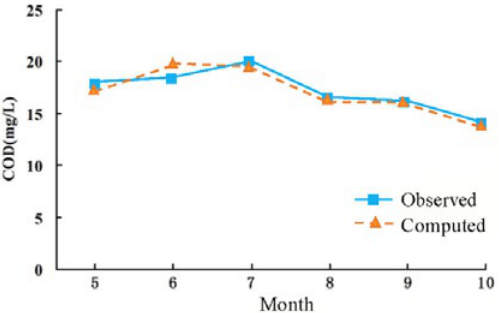
Fig. 6: Verification of COD Cr in Chenggaozi cross-sec (cid:415) on (2012)